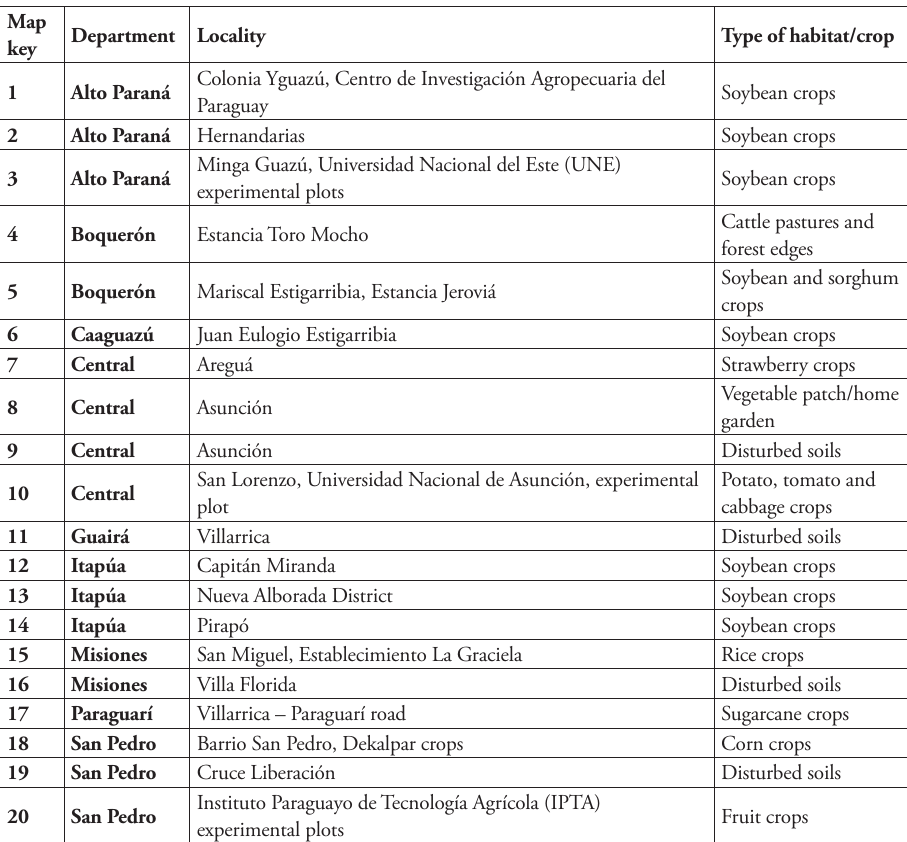
Table 1. Crop weed collection